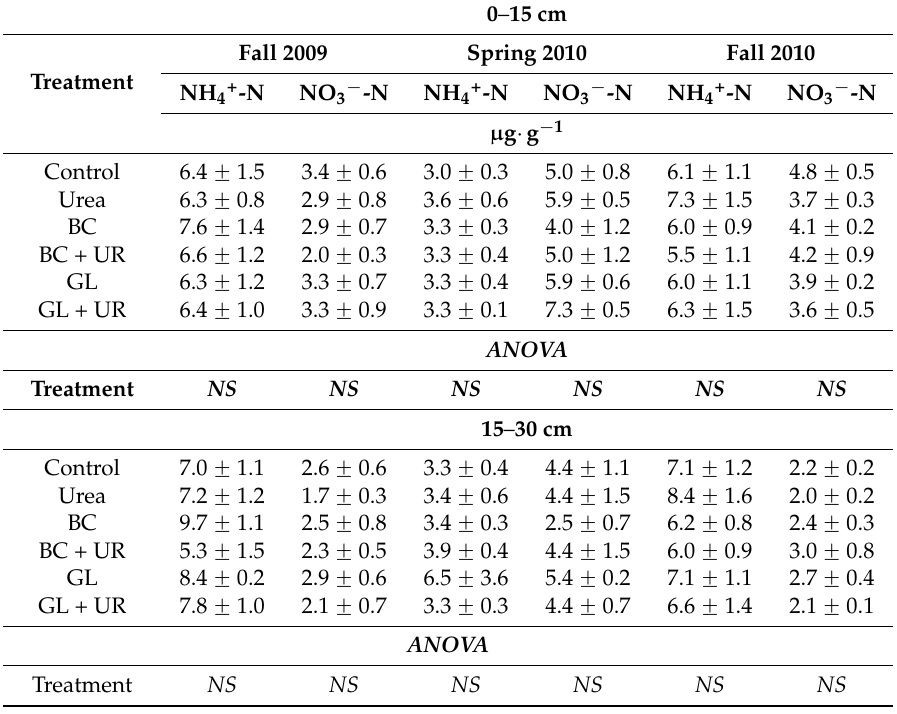
Table 5. Soil content of inorganic N (NH 4 + -N, NO 3 ´ -N) at two soil depth increments determined in soils collected after crop harvest in 2009, before planting in 2010 and after crop harvest in 2010 (mean ˘ standard